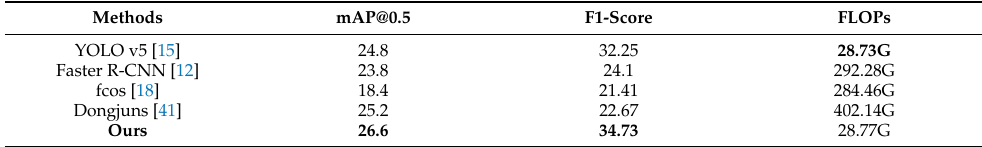
Table 5. Performance comparison on CNRDD